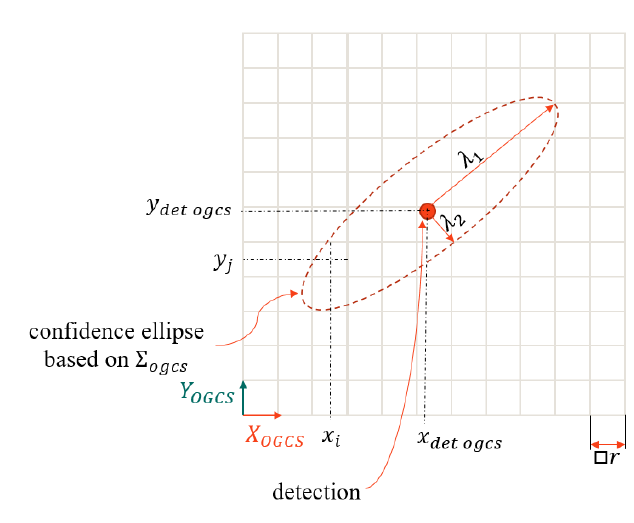
Figure 8. Confidence ellipse around the detection with semi-major axis a , semi-minor axis b , and center coordinates x i , y j of the cell g ij .